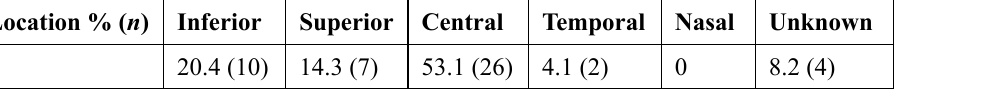
Table 1 . Cone location for 49 eyes is presented. One subject only had one eye. In two patients the location of the cone could not be decided upon due to the distorted state of the corneas.